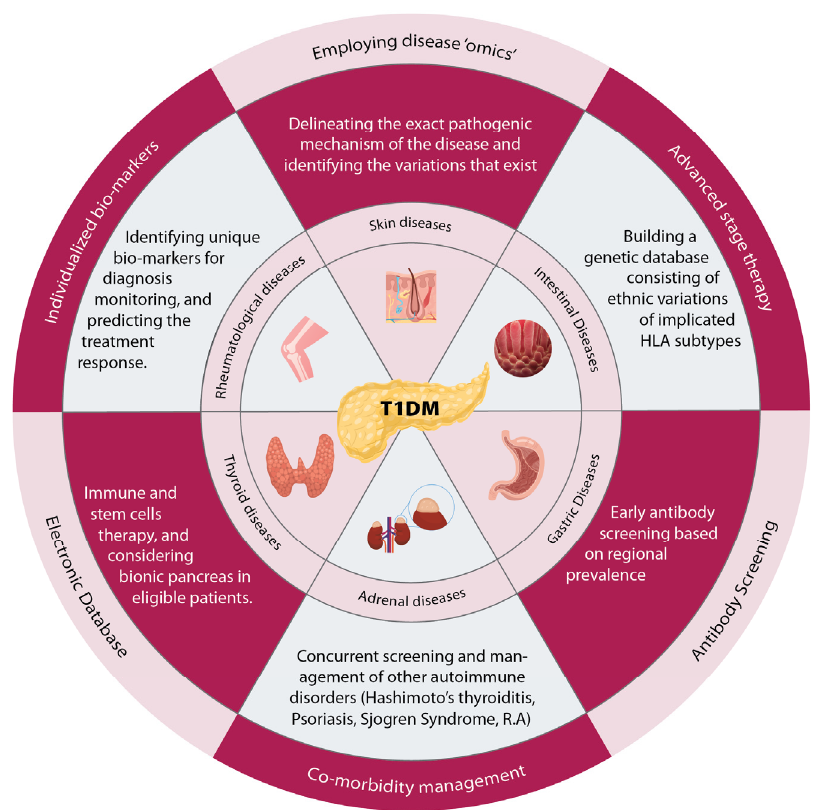
Figure 1. Personalized Medicine as an approach to T1DM and associated autoimmune diseases. T1DM is associated with multiple other endocrine abnormalities — including thyroid, adrenal, gastrointestinal, rheumatological, and dermatological — that might be inapparent initially. Suggested approaches for managing these conditions are based on maintaining an electronic database with a recording of antibody screening and identifying biomarkers.